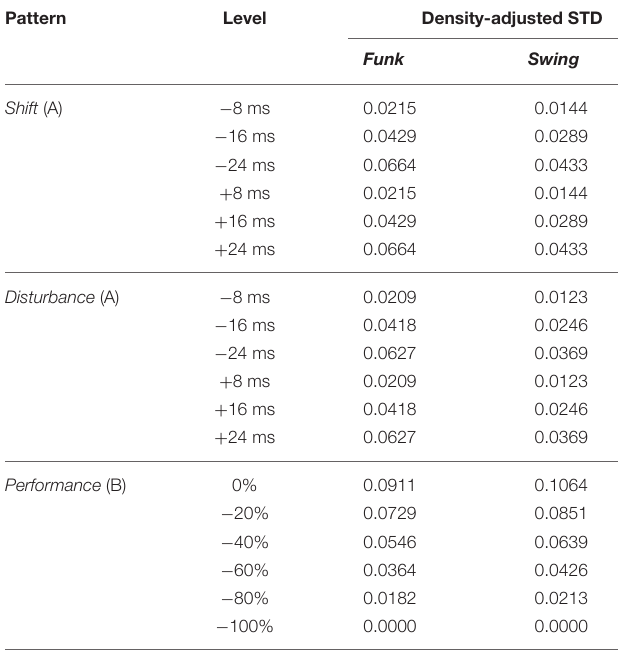
TABLE 5 | Density-Adjusted STD values for the stimuli of the Shift , Disturbance and Performance microtiming patterns. Pattern Level Density-adjusted STD Funk